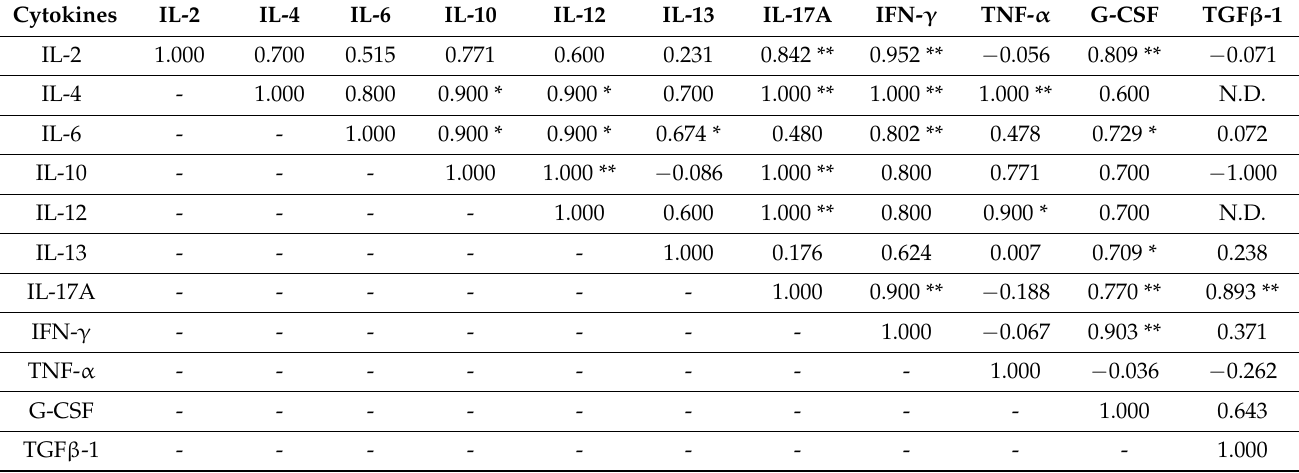
Table 5. Correlation (Spearman Rho) matrix between cytokines investigated in the present